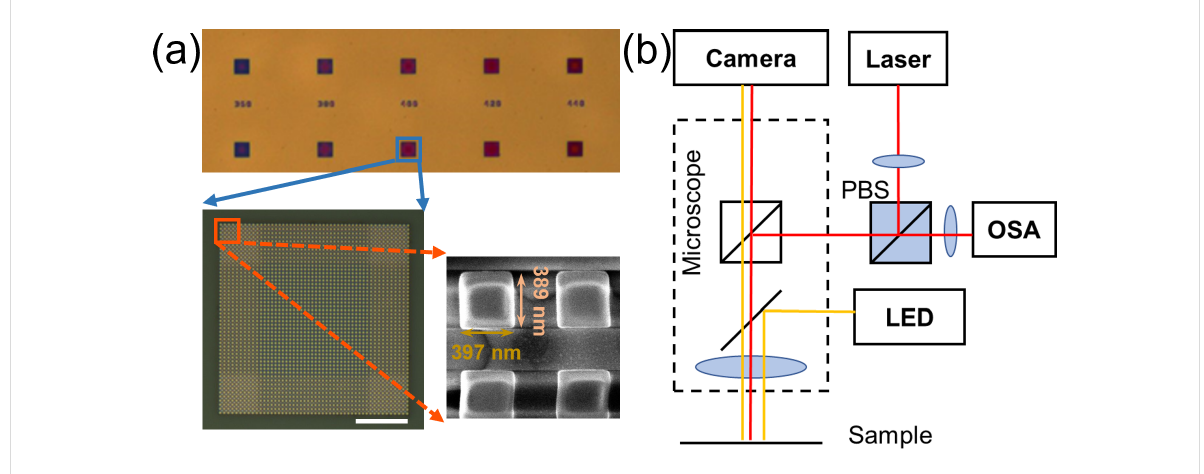
Figure 3: Fabricated samples and optical setup. (a) Optical and scanning electron microscopy images of fabricated samples, scale bar: 10 μ m. (b) Diagram of the experimental setup. The yellow and red lines indicate the imaging and measurement light paths, respectively. PBS: polarization- dependent beam splitter; OSA: optical spectrum